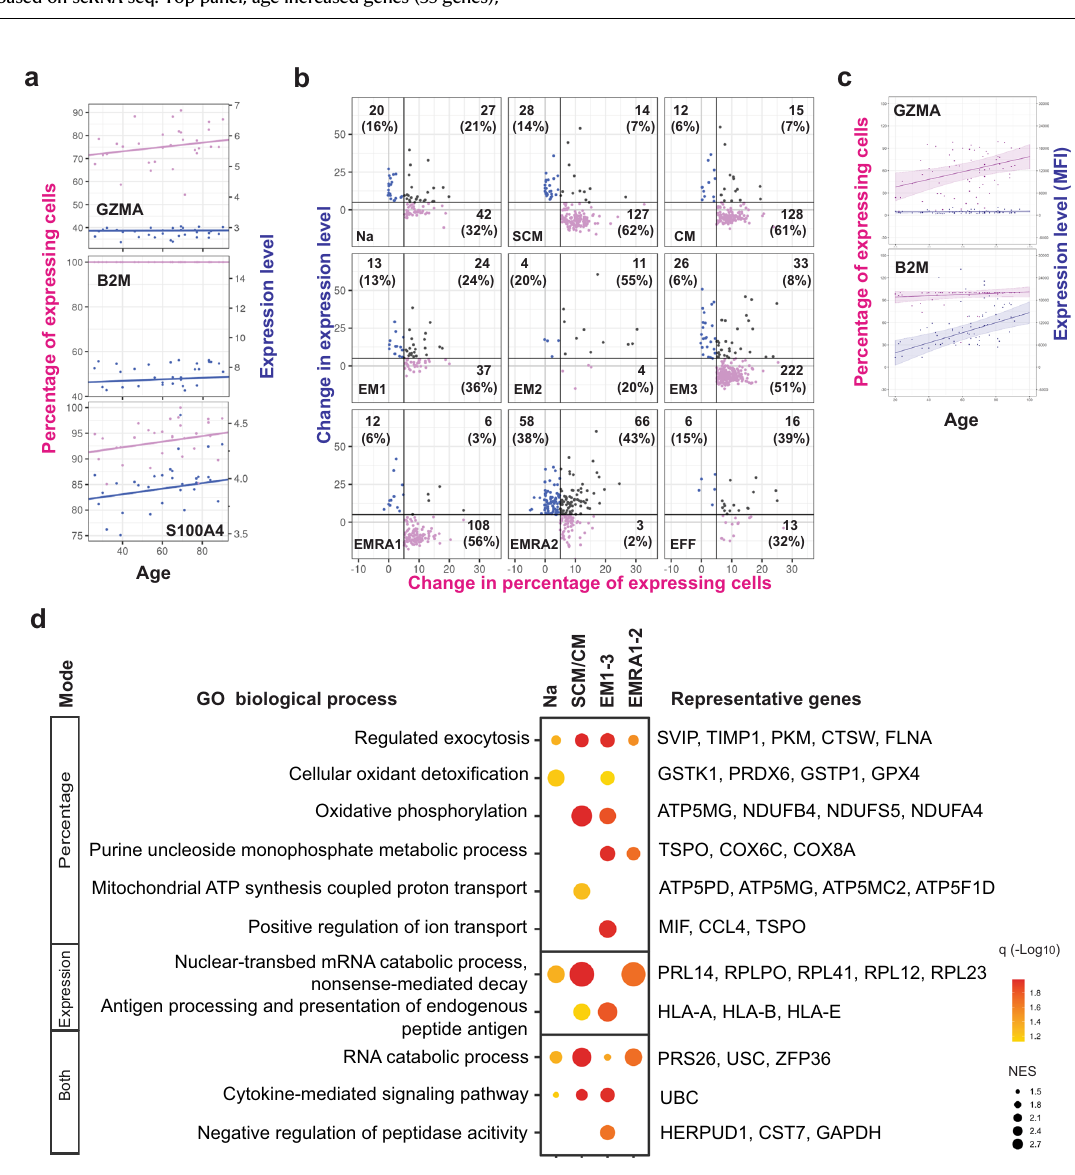
Fig. 3 | Modes of age-associated increased gene expression in CD8 + T cell sub- populations. a Three distinct modes of gene expression increase with aging in CD8 + T cells. A representative gene is shown for each mode. From top to bottom, GZMA increases in the number of expressing cells(represented by percentage in a donor); B2M increases by expression level in cells (represented by percentage increase in UMI counts); and S100A4 increases by number of expressing cells and by expression level. Trend lines were from the lineage regression model for which the t distribution with n-2 degrees of freedom was used to evaluate if a slope was signi fi cant for a particular variable (2 sided t-test) used here and in c . b Classi fi cation of signi fi cant age-related increases in gene expression into three modesineachCD8 + Tcellsubpopulations(Na,naiveadult;SCM,stemcellmemory; CM central memory, EM1, 2, 3, effector memory subpopulations 1, 2, 3; EMRA1, 2